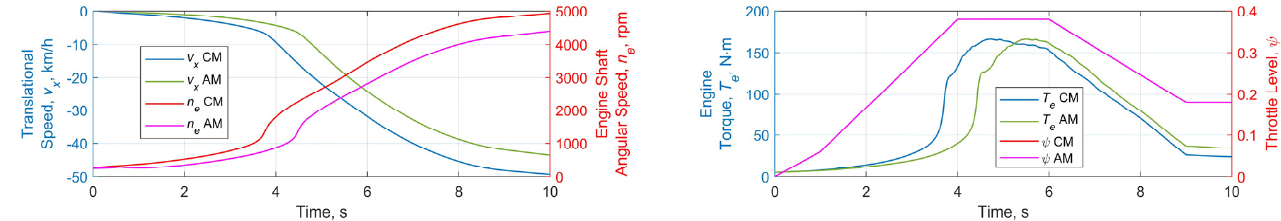
Figure 10. The main models’ parameters for comparing at reverse driving.